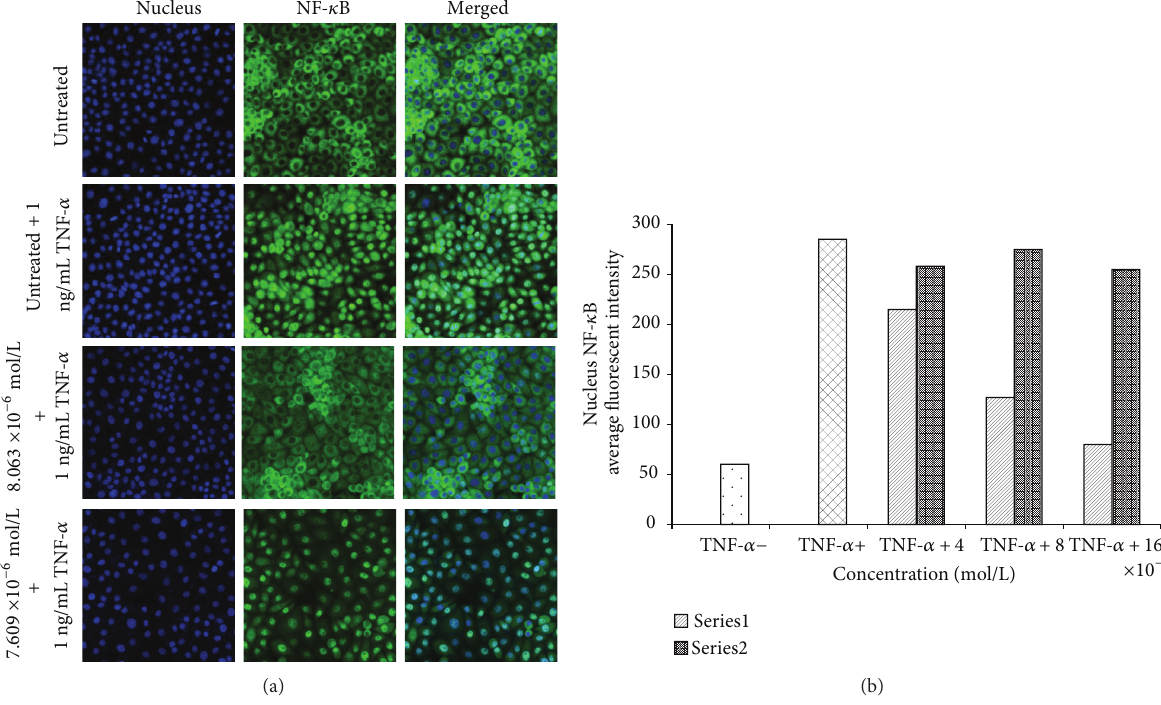
Figure 16: NF- 𝜅 B translocation. (a) Photographs of the intracellular targets of stained MCF-7 cells that were exposed to (1) and (2) at concentrationsof8 × 10 −6 mol/Land7.6 × 10 −6 mol/L,respectively,for3hoursandthenstimulatedfor30minuteswith1 ng/mLTNF- 𝛼 (NF- 𝜅 B